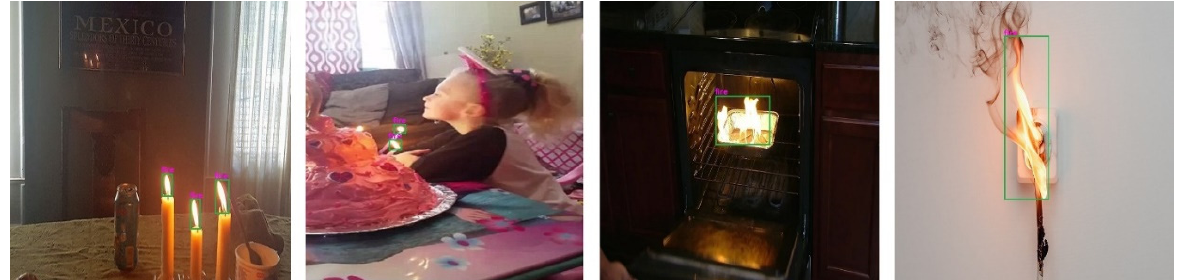
Figure 10. Visual results of the proposed fire detection system for different small-sized fire scenes.